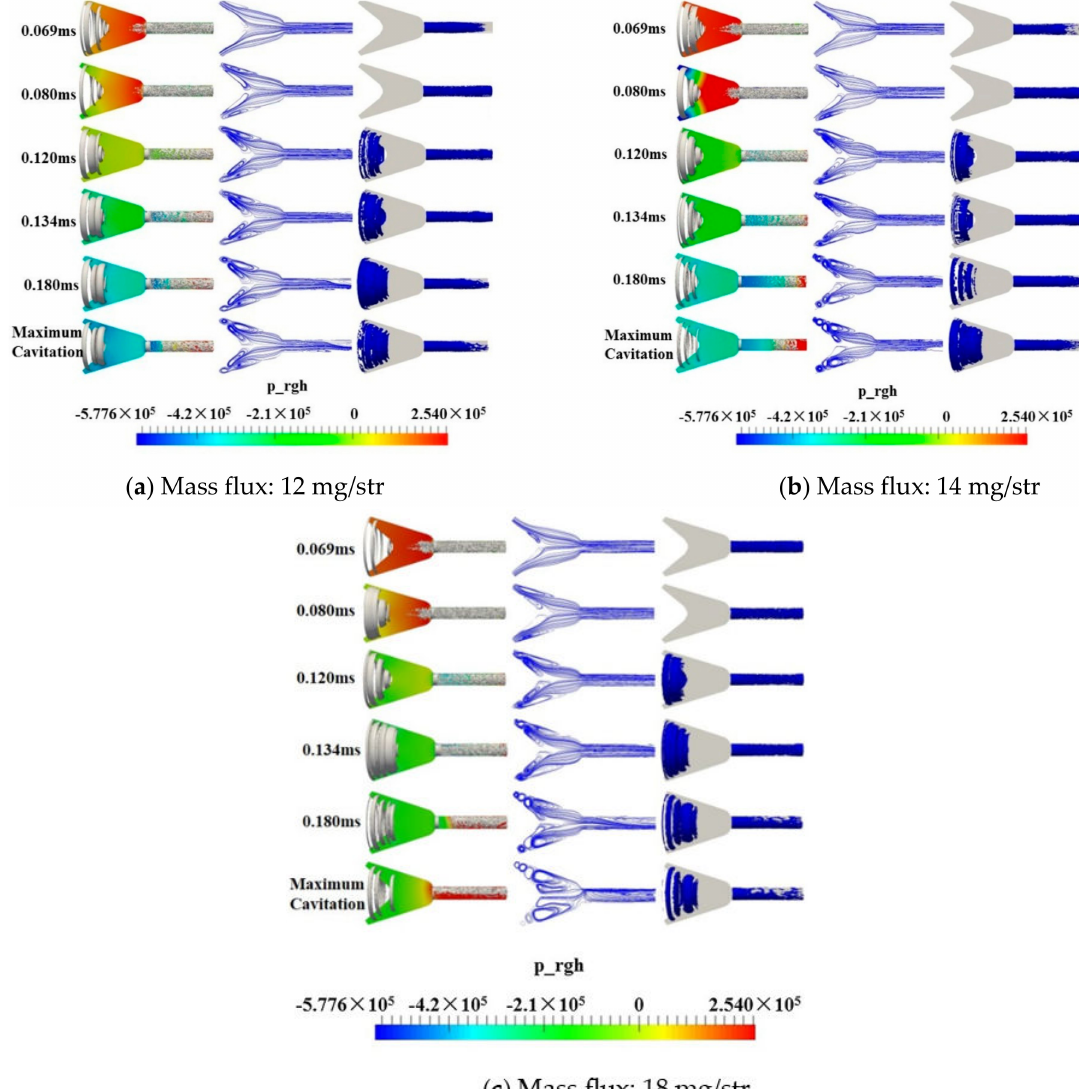
Figure 12. Q = 2 × 10 9 iso-surface, streamline, and α = 0.25 vapor iso-surface in the nozzle at different mass